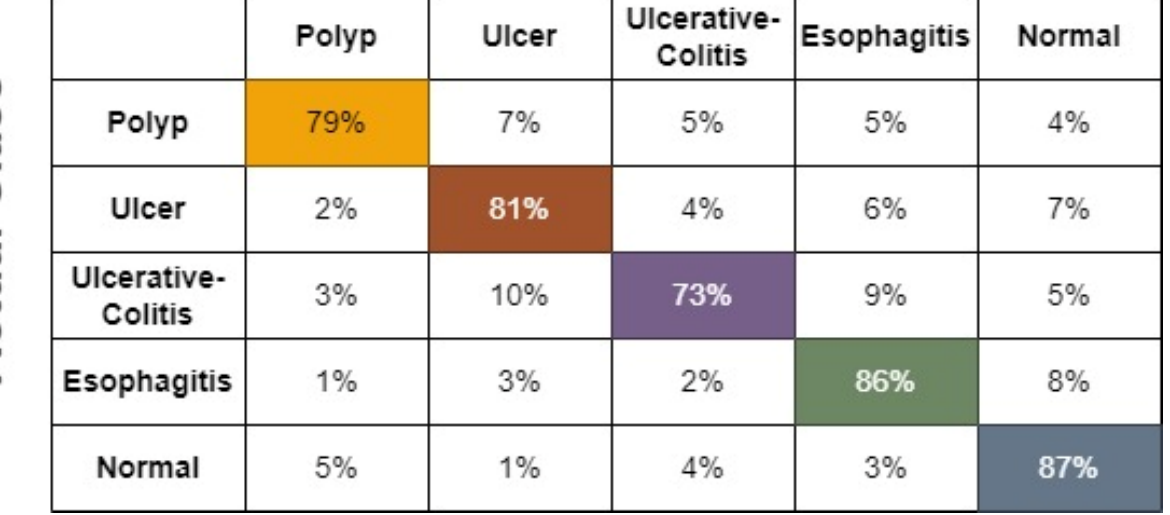
Figure 6. Confusion matrix using softmax classifier for original dataset.